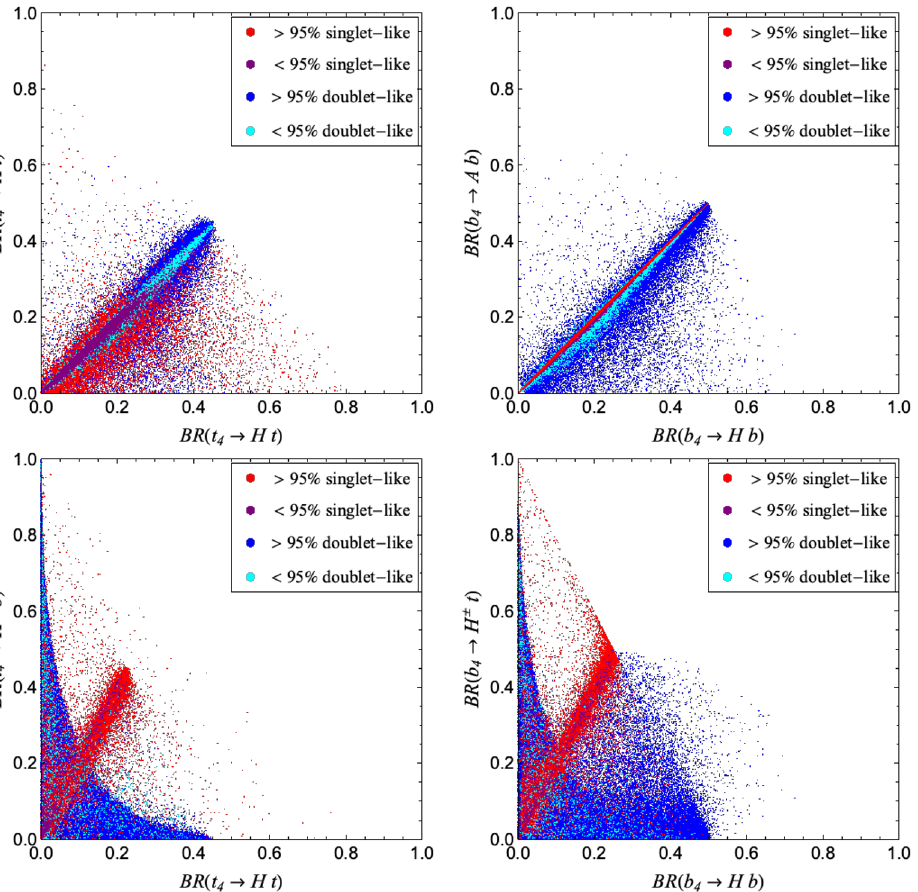
Figure 3 . The allowed branching ratios of t 4 and b 4 into heavy charged and neutral Higgses in the general scenario with all couplings allowed. The new quark is 95% or more singlet-like (red), 50%-95% singlet-like (purple), 50%-95% doublet-like (cyan) or 95% or more doublet-like (blue). In all (cid:12)gures, decay modes through any heavy Higgs boson are allowed and m H = m A = m H (cid:6) = 1 TeV is assumed. Other details of the parameter space scan are the same as in ref.